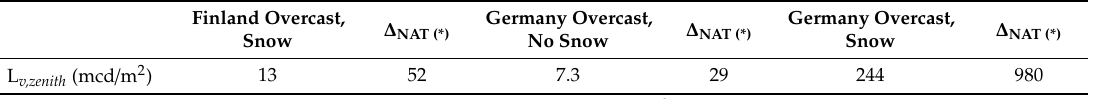
Table 5. Comparing the parameters of the winter overcast nights in Finland and Germany to the summer reference measured in Latvia and calculating the amplification using the summer reference. Latvia Finland Germany Germany ∆ ∆ ∆ Overcast Overcast, Overcast, Overcast, FI, CL, SN (*) GER, CL (**) GER, CL, SN (***) Reference Snow No Snow Snow L v,zenith (mcd / m 2 ) 0.07 13 185 7.3 104 0.22 0.40